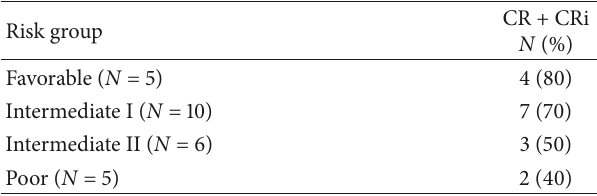
Table 2: Response stratified by genetic risk